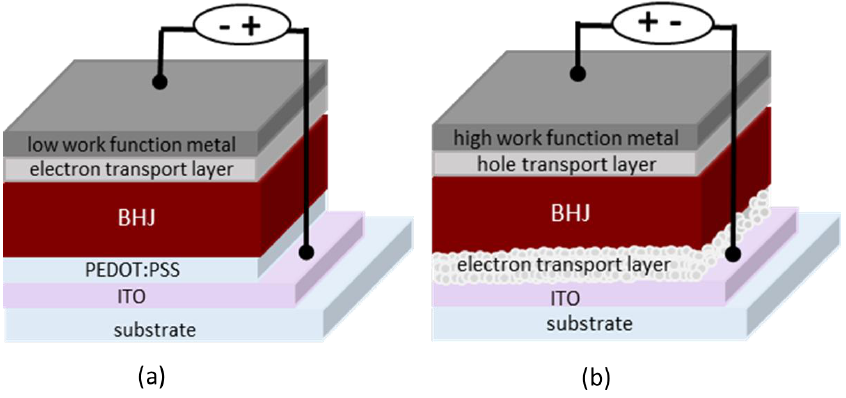
Figure 3. Device architecture of ( a ) conventional and ( b ) inverted PSCs.